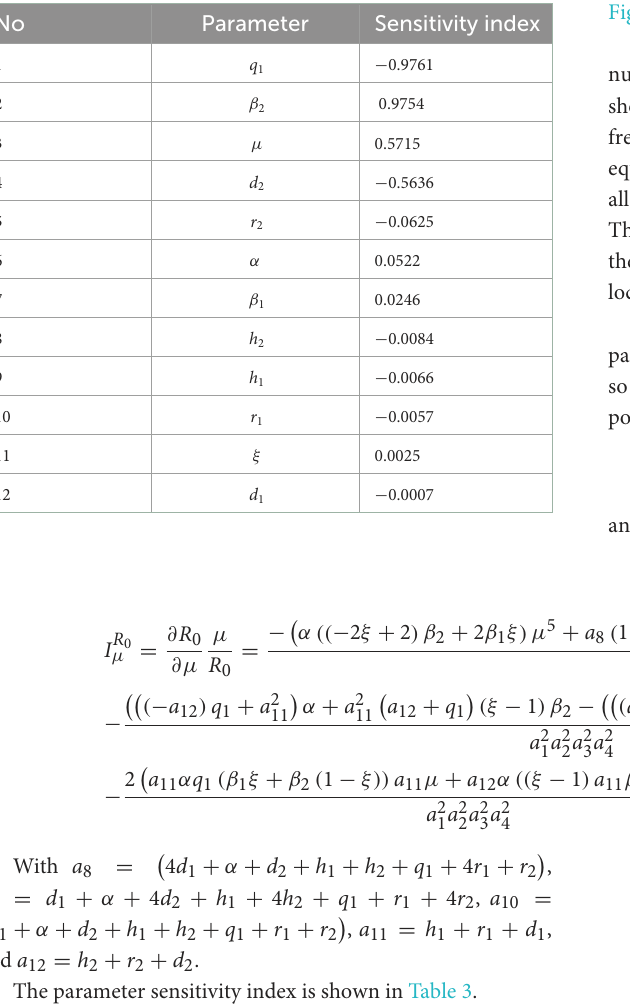
TABLE 3 Sensitivity